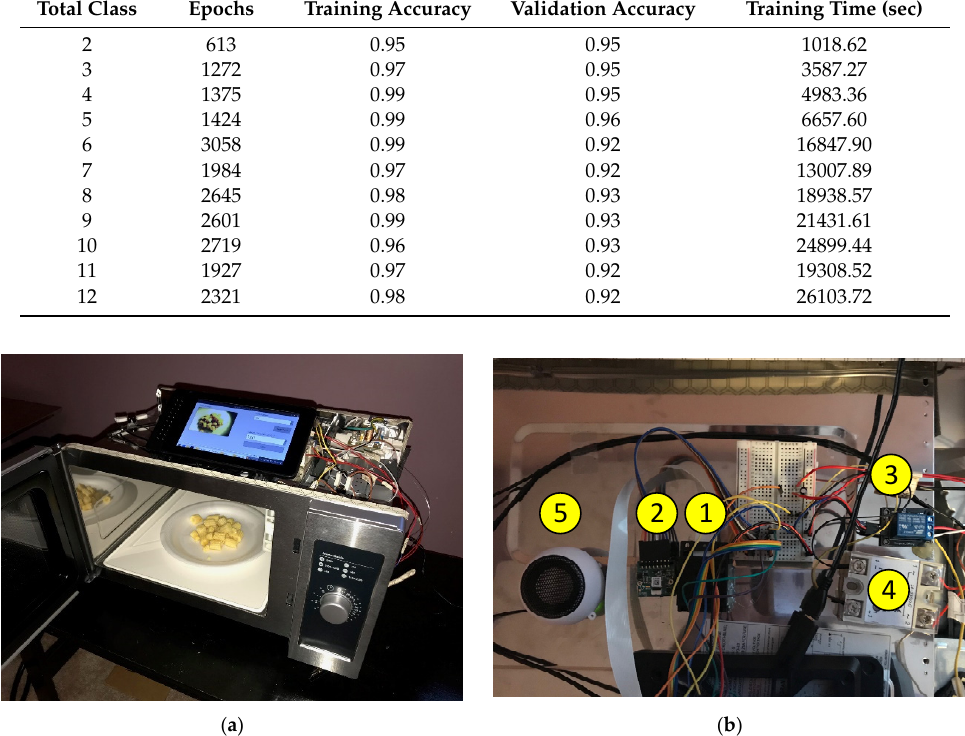
Table 2. Training and validation accuracy and timing for di ff erent number of classes.